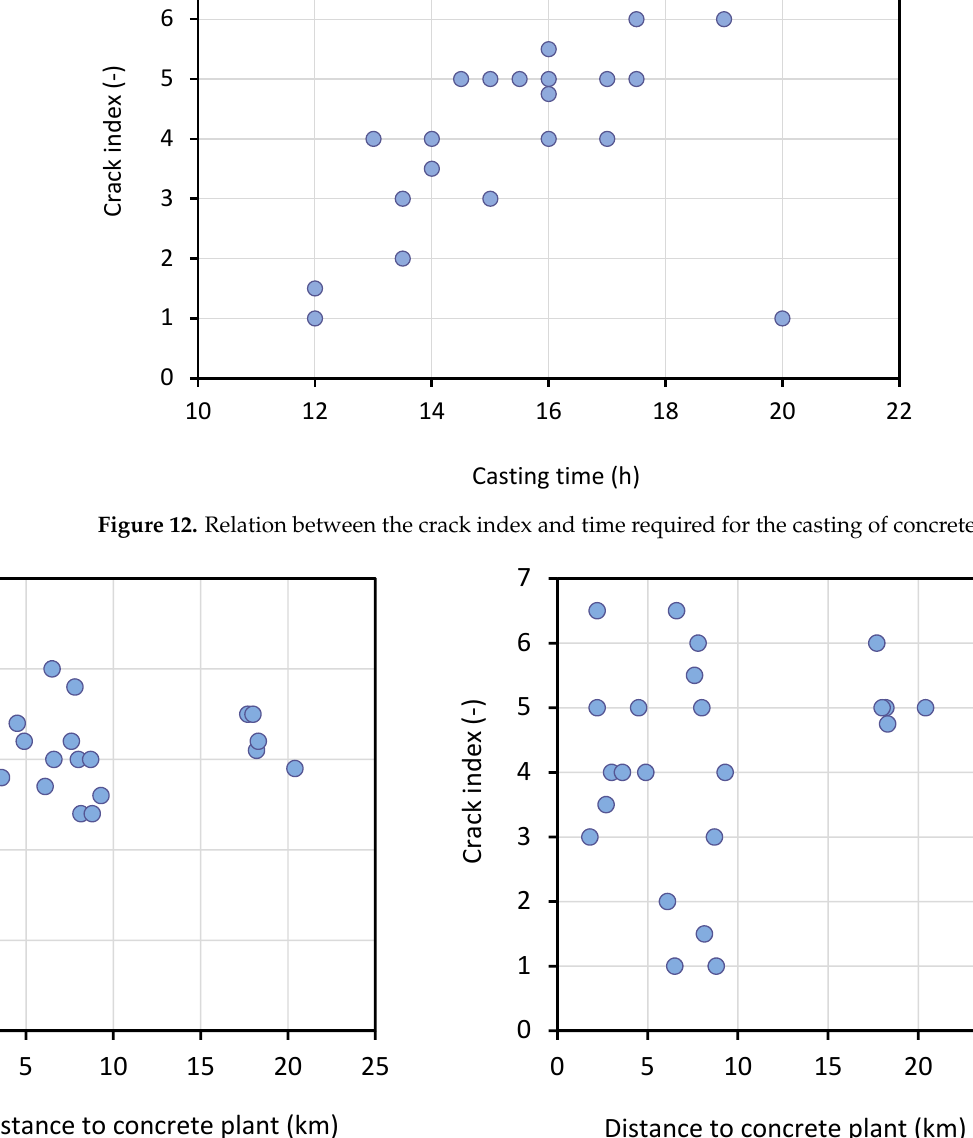
Figure 12. Relation between the crack index and time required for the casting of concrete.